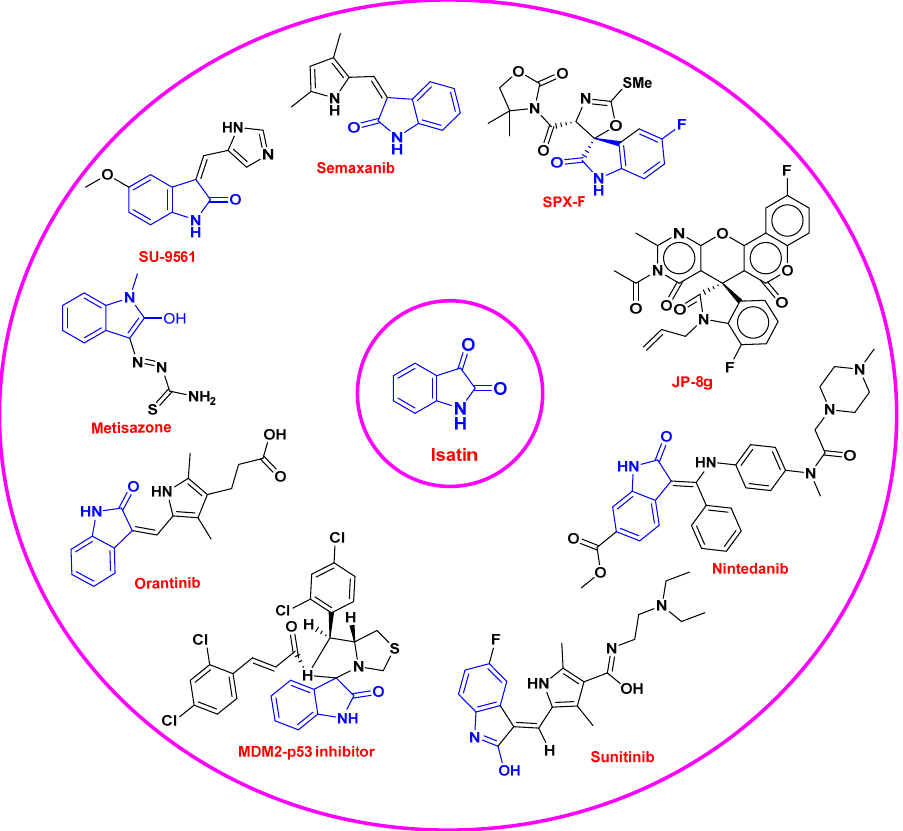
Figure 2. Marketed candidates containing isatin moiety.